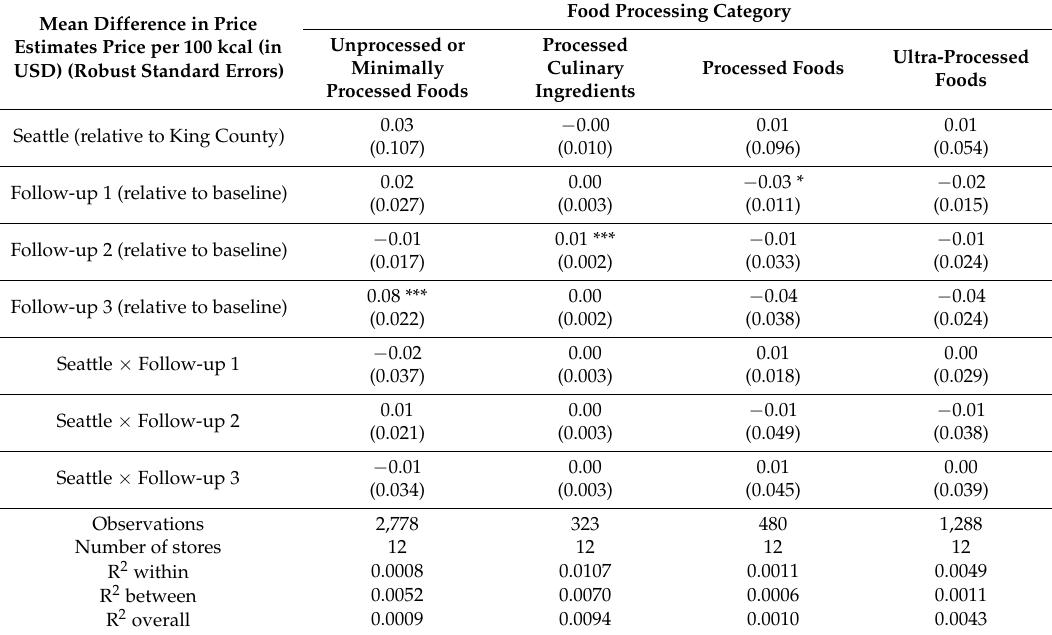
Table 2. Food processing category stratified linear difference-in-differences model results for the mean change in item-level price per 100 kcal across Seattle (‘intervention’) and King County (‘control’) stores and over time from March 2015 to May 2017, before and during implementation of Seattle’s minimum wage